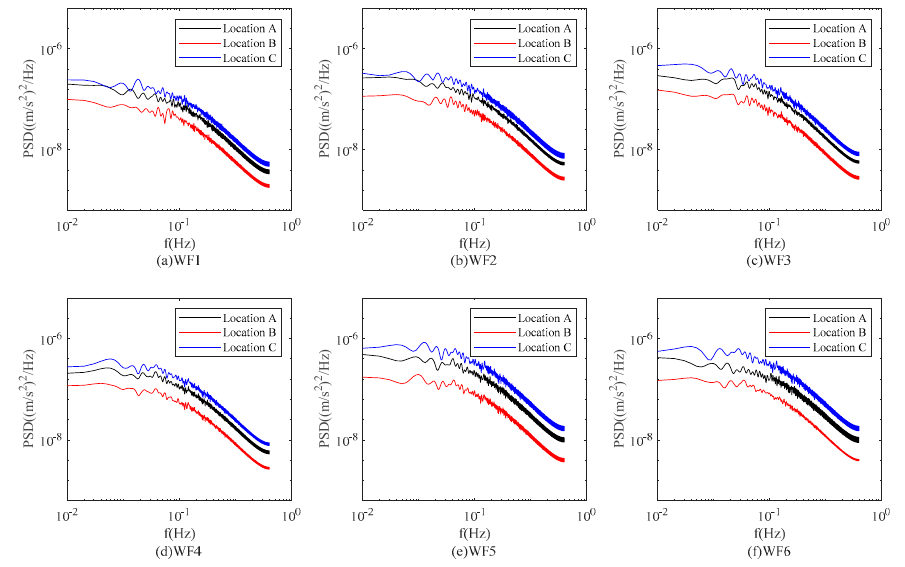
ff erent locations. ( a )–( f ) Wind Fields Figure 10. Acceleration spectrum at different locations. ( a )–( f ) Wind Fields (WF)1–6. Figure 10. Acceleration spectrum at di